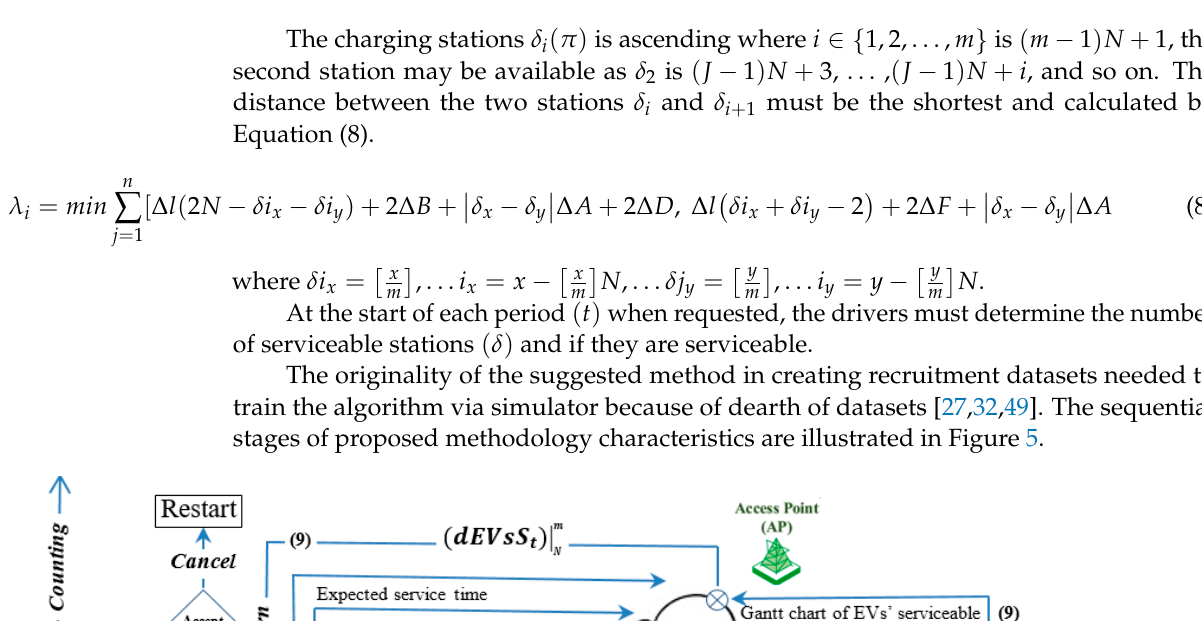
Figure 4. The spatial distribution of chargers in the city of Dundee and EVs allocation via Zap Map (source: https://data.dundeecity.gov.uk/dataset/ev-charging-data, accessed on 28 January 2022).